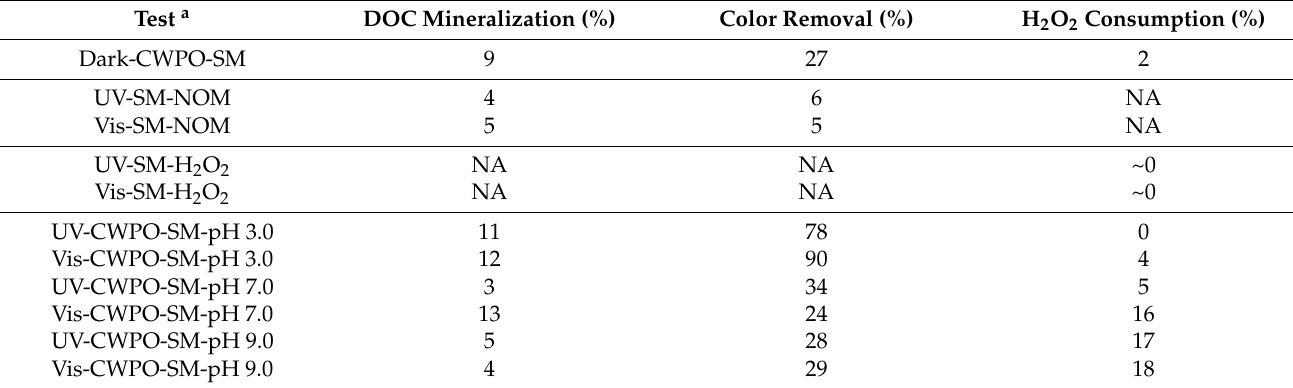
Table 2. Photo-CWPO degradation of NOM by the starting mineral clay